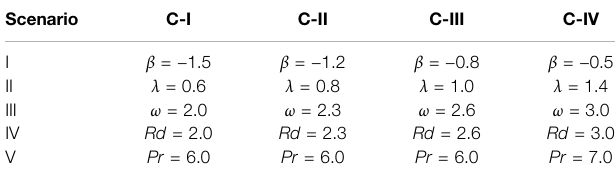
TABLE 3 | Variation of parameters for the unsteady three-dimensional fl ow of hybrid nano fl uid over a stretchable and rotatory sheet problem.